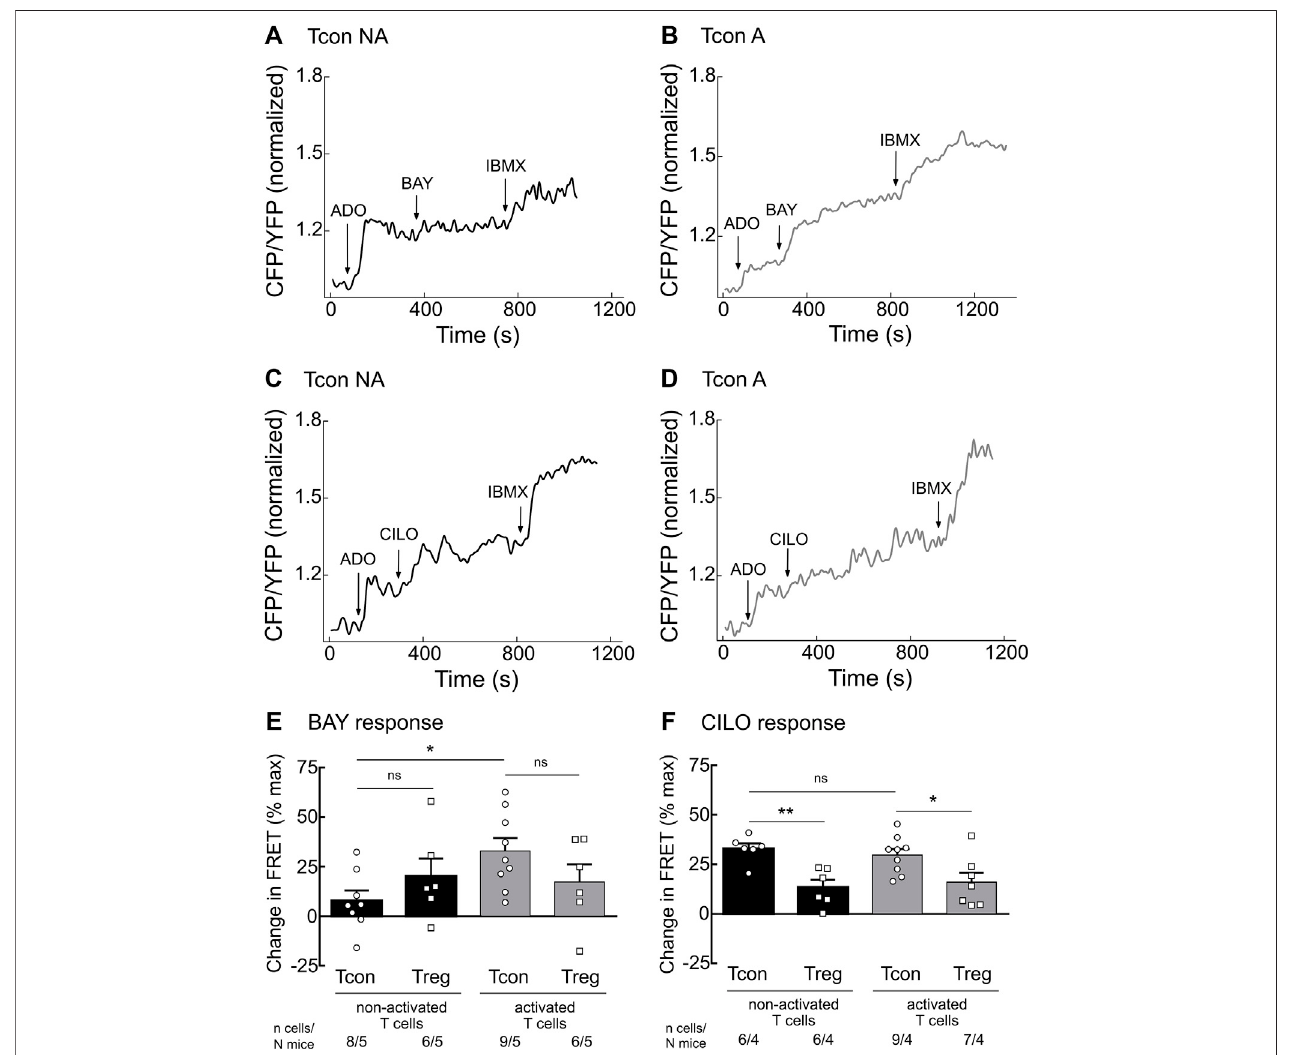
FIGURE2| Live-cellimagingofPDE2andPDE3inhibitoreffectsinthecytosolofnon-activated(NA)andactivated(A)Tcells.MurineTconandTregisolatedfromCAG- Epac1-campsmicewereculturedfor16 – 24 hinthepresenceorabsenceofanti-CD3/CD28DynabeadsandusedforFRETbasedlive-cellrecordings.Representativetraces fromFRETmeasurementsfor (A) non-activatedand (B) activatedTconuponPDE2AinhibitionbyBAY(100 nM)and (C) non-activated and (D) activatedTconuponPDE3B inhibitionbyCILO(10 µM)areshown.Tcellswere fi rstprestimulatedwithadenosine(ADO,10 µM)toinducecAMPproduction. (E,F) Quanti fi cationofFRETresponses shown in A-D, together with Treg responses, upon stimulation with (E) BAY or (F) CILO of individual cells measured are presented as percent of maximal FRET biosensor responsegeneratedbyIBMX(100 µM).DecreaseincAMPlevelisshownasanegativevalue.Resultsaredepictedasmean ± SEM.Cellnumber( n )andtotalnumberofmice ( N ) per group are indicated below the bars. * p < 0.05, ** p < 0.01, ns – not signi fi cant by one-way ANOVA followed by Sidak ’ s multiple comparison